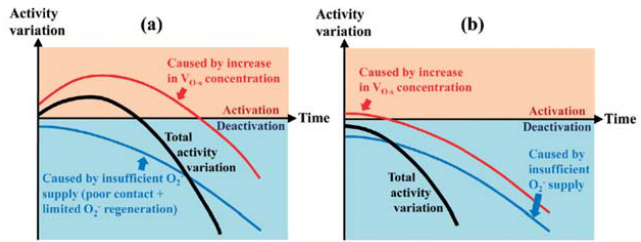
Figure 13. Schematic explanation for activity variations over ( a ) Ag/CeO 2 with low initial V O-s concentration (e.g., AgCe-0, AgCe-0.01, AgCe-0.02 and AgCe-0.03) and ( b ) Ag/CeO 2 with high initial V O-s concentration (e.g., AgCe-0.04 and AgCe-0.05) during isothermal soot oxidation. Reproduced from Ref. [112] with the permission from the Royal Society of Chemistry.